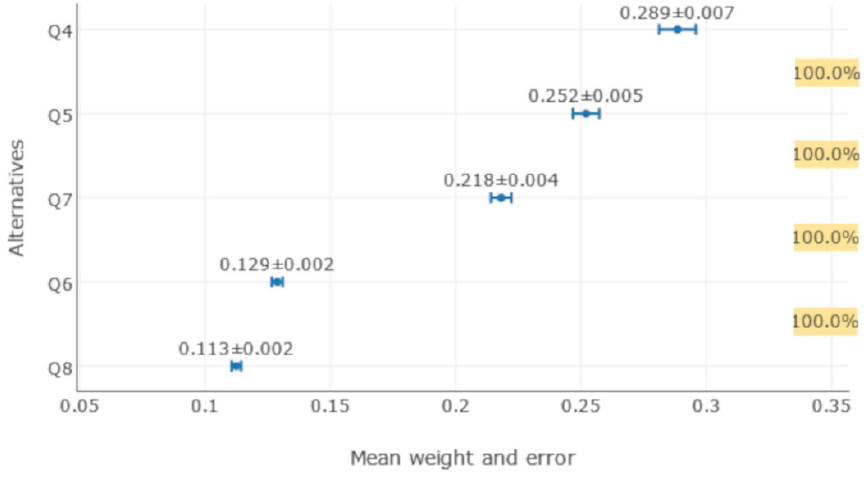
Figure 3. Alternatives (questions’ importance) comparison results with their mean weights, absolute errors, and ranking probabilities of compared alternatives Q4–Q8.